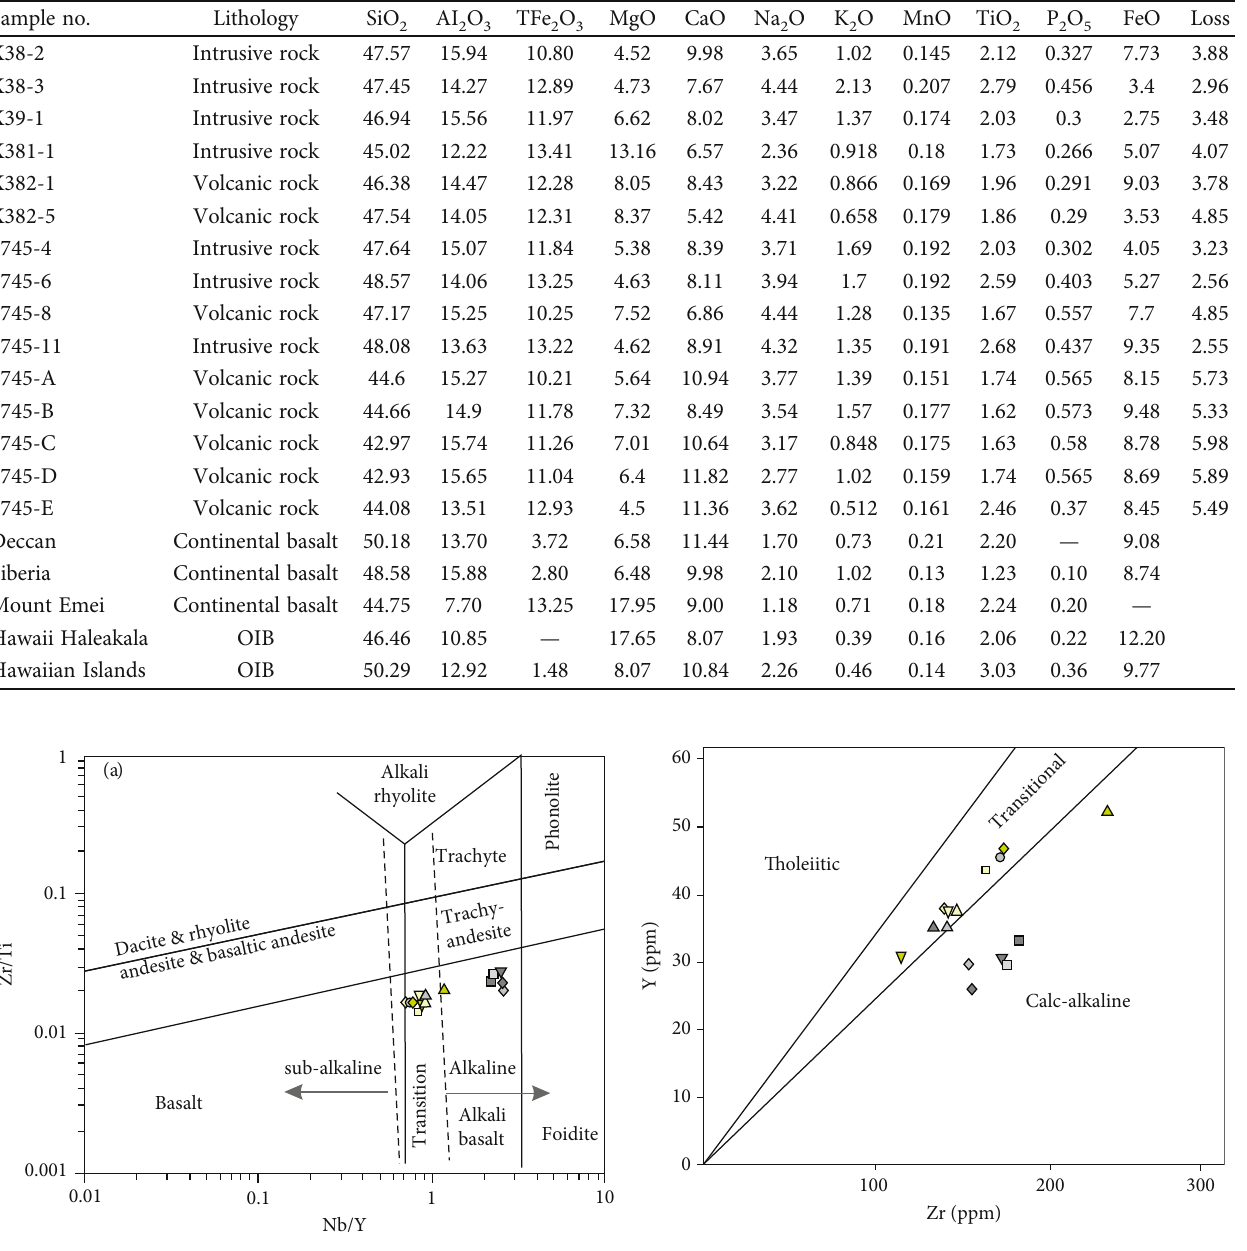
Table 1: Major element (%) compositions for Paleogene igneous rocks in Huimin Sag. Sample no.